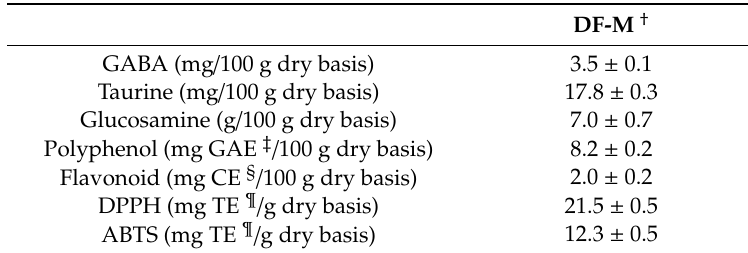
Table 5. The γ -Aminobutyric acid (GABA), taurine, glucosamine, polyphenol, and flavonoid contents and radical scavenging activities of defatted